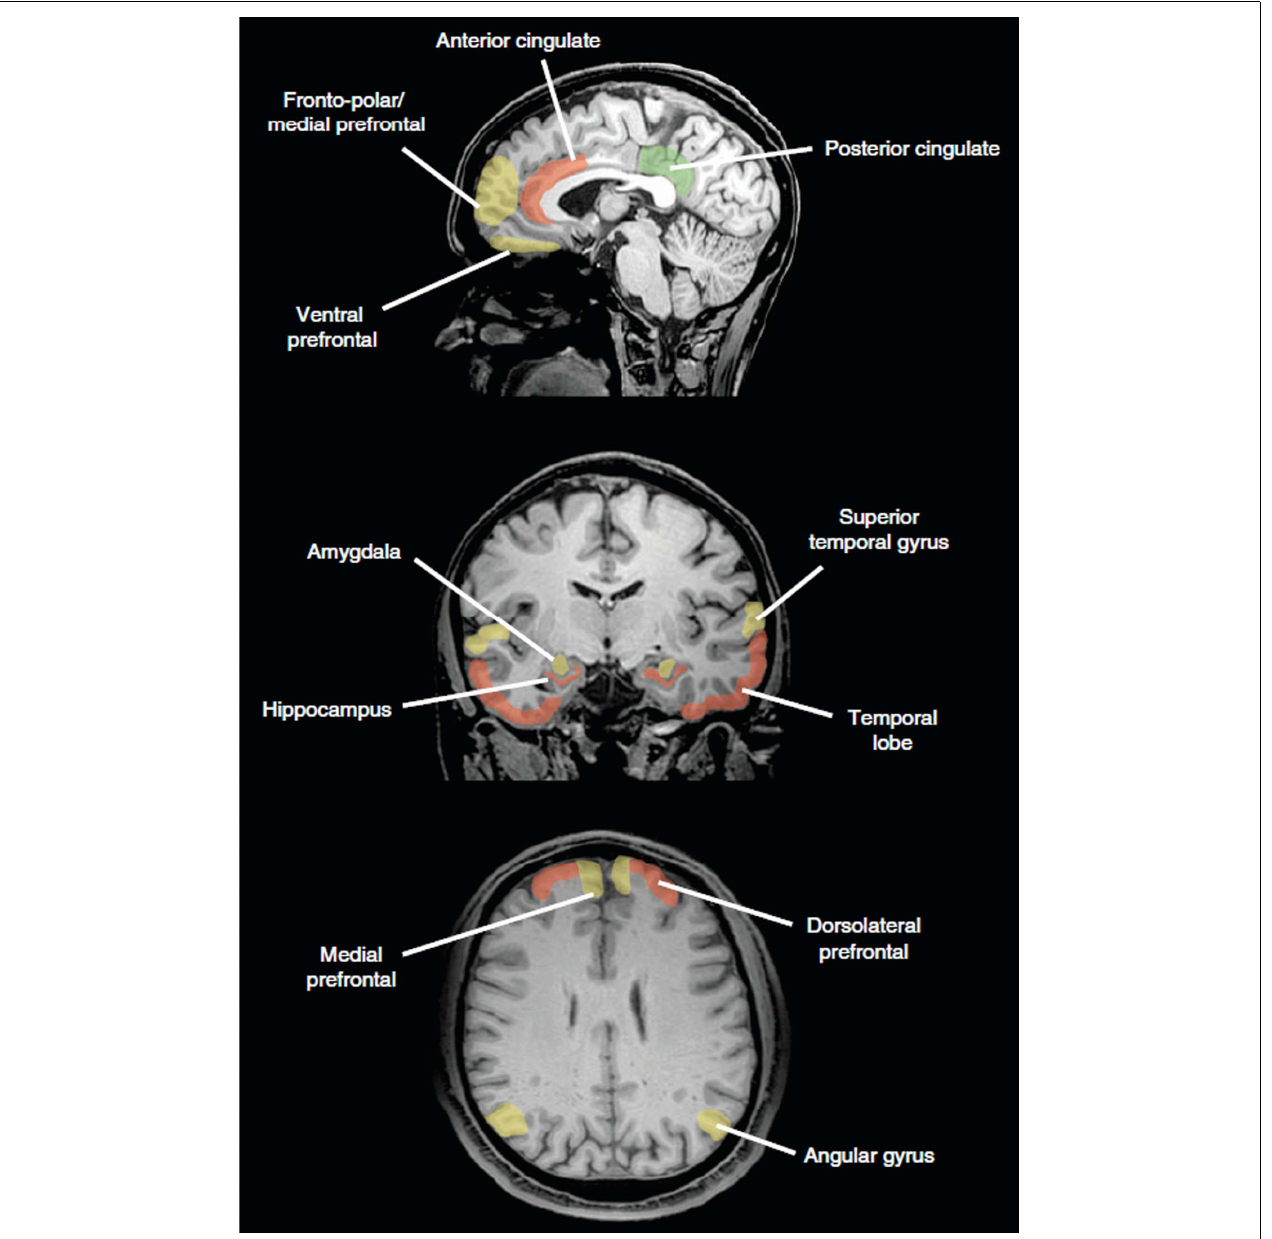
interpretation is that emotions as underpinned by the common regions prevent breaking of moral rules, the defining deficit of antisocial personality disorders.The angular gyrus lies at the junction of temporal and parietal cortex. Reprinted with permission from Raine andYang